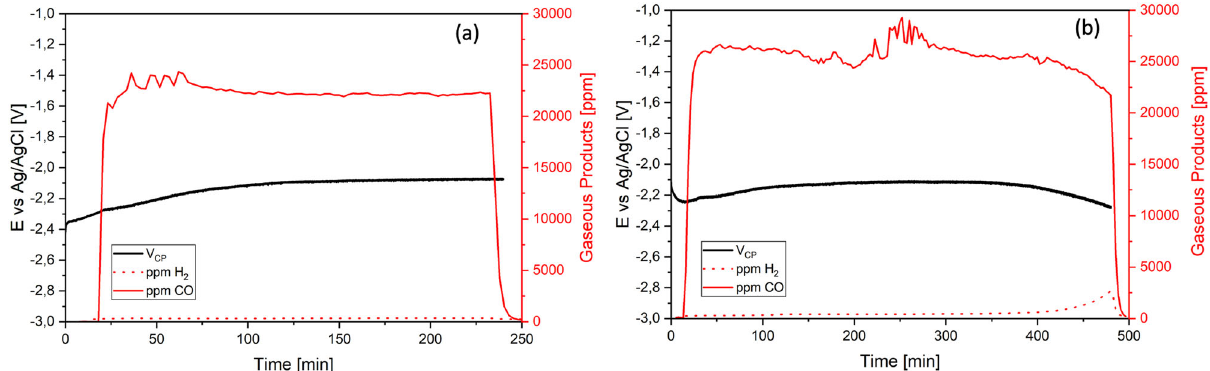
Fig. 7 Stability test of [BMIM][SO 3 CF 3 ] electrolyte during the electrocatalytic CO 2 reduction reaction on Ag electrode. a CP for 8 h at − 20 mA with 0.3 M [BMIM][SO 3 CF 3 ] in ACN. b CP for 8 h at − 60 mA with 0.3 M [BMIM][SO 3 CF 3 ] in ACN. Black line represents the trend of potential at the fi xed current value. Continuous and dotted red lines correspond to the CO and H 2 concentrations in the outlet gas, respectively. Set-up: H-cell; WE: Ag foil; catholyte: 0.3 M IL in ACN; CE: Ni mesh; anolyte: 0.1 M KOH.